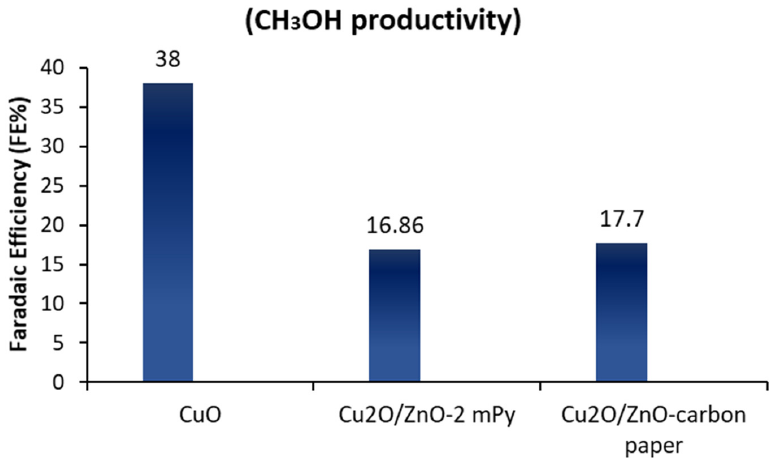
Figure 10. CH 3 OH production using copper oxide ‐ based catalysts.